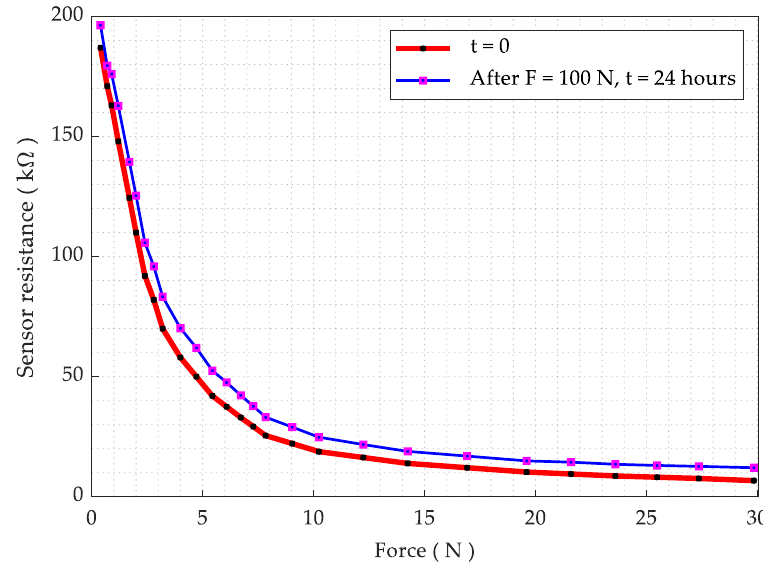
Figure 8. Resistance as a function of applied force.